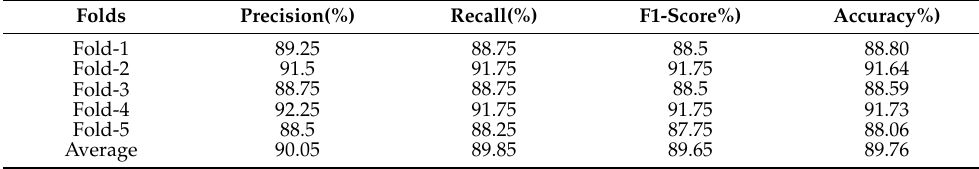
Table 9. Performance of the proposed model on each fold.